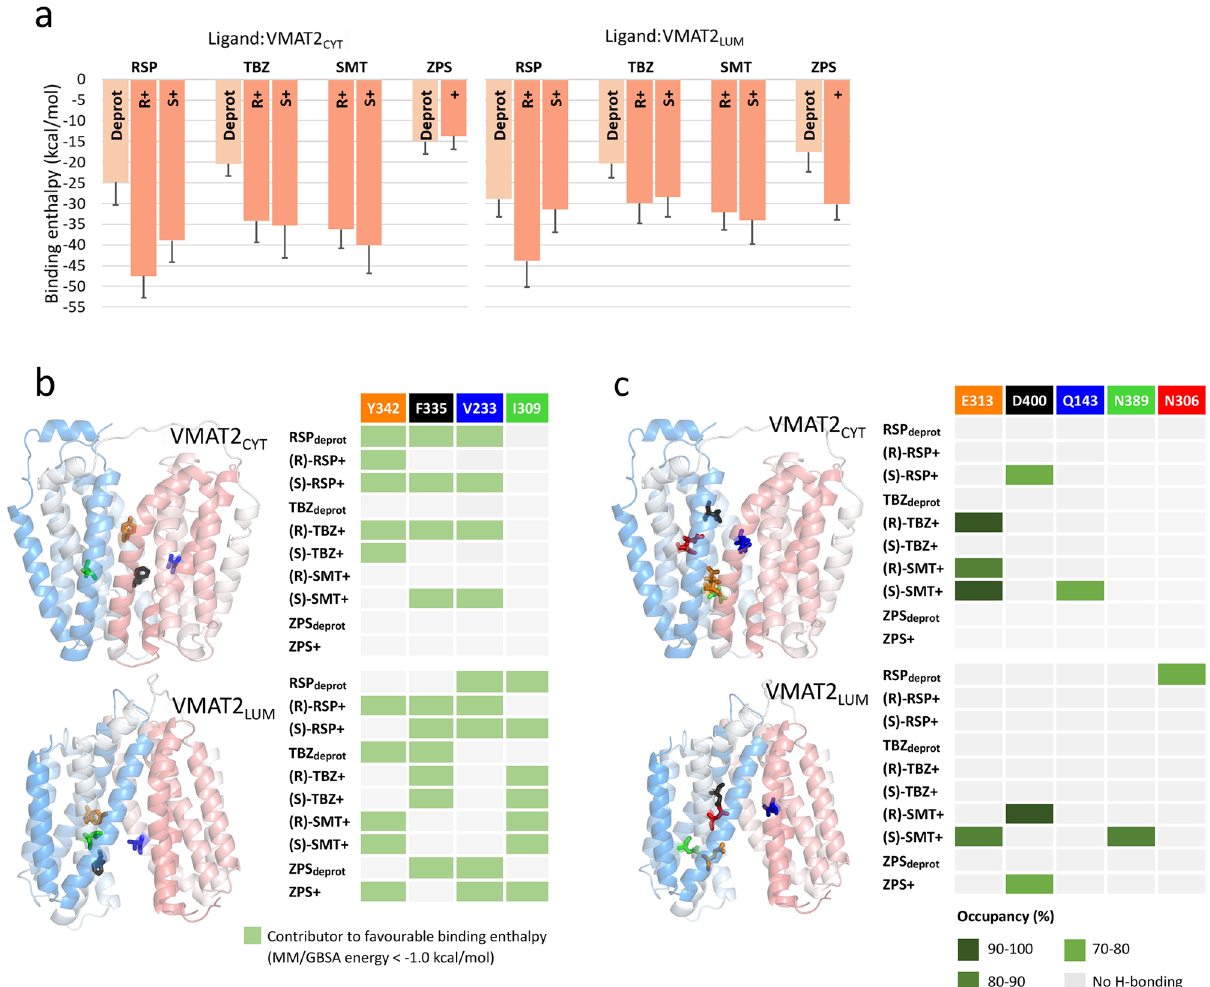
Fig. 4 Binding enthalpies and “ hot spot ” VMAT2 residues from MD simulations. a Implicit membrane MM/PBSA binding enthalpies calculated from simulations of all ligand states, for reserpine (RSP), tetrabenazine (TBZ), salmeterol (SMT) and ziprasidone (ZPS) bound to the cytoplasm-facing VMAT2 model (left) and the lumen-facing VMAT2 model (right), and displayed as light colored bars for neutral, deprotonated ligand states and as dark orange bars for the protonated forms. Bars represent the average calculated binding enthalpy ±SD, calculated from 1000 frames from the last 200 ns of each simulation. b “ Hot spot ” residues. The four VMAT2 residues most frequently found among the main contributors to favorable enthalpy across all the simulation systems, along with their locations in the cytoplasm-facing (top) and lumen-facing (bottom) rat VMAT2 homology models, with VMAT2 colored by sequence from the N-terminal in red to the C-terminal in blue. Main contributors for each system were de fi ned as residues with a more favorable decomposed MM/GBSA energy than − 1.0 kcal/mol. Consult Table 2 for a more comprehensive overview. c Hydrogen bonding. Ligand:VMAT2 interaction partners displaying one or more hydrogen bonds present for more than half of the simulation time, i.e., hydrogen bonds with occupancies higher than 50%, and the locations of the relevant VMAT2 residues in the cytoplasm-facing (top right) and lumen-facing (bottom right) homology models. Consult the 2D ligand interaction diagrams in Supplementary Fig. 3 for more